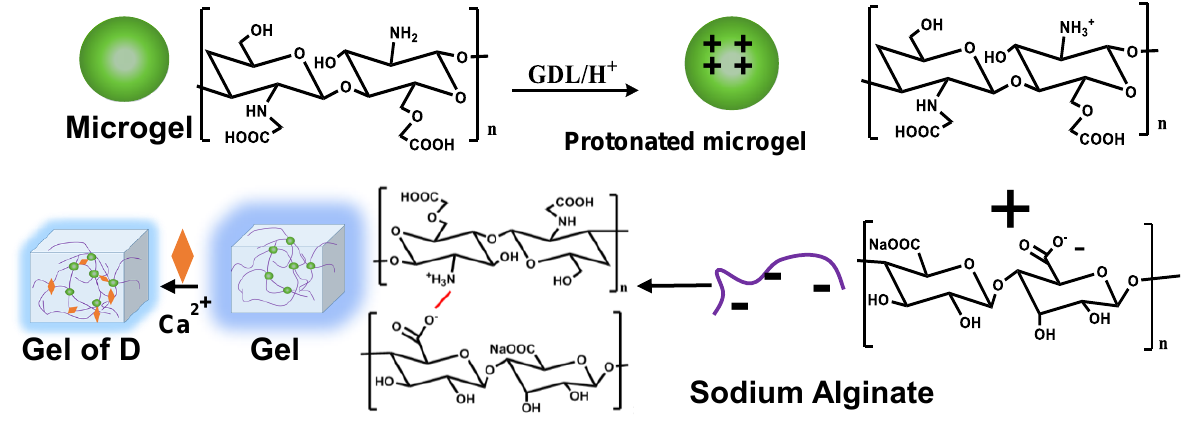
Figure 2. The scheme of hydrogel Figure 2 . The scheme of hydrogel preparation.